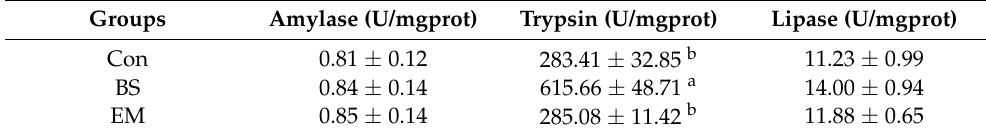
Table 4. Effects of probiotics on digestive enzyme activity of M. rosenbergii .